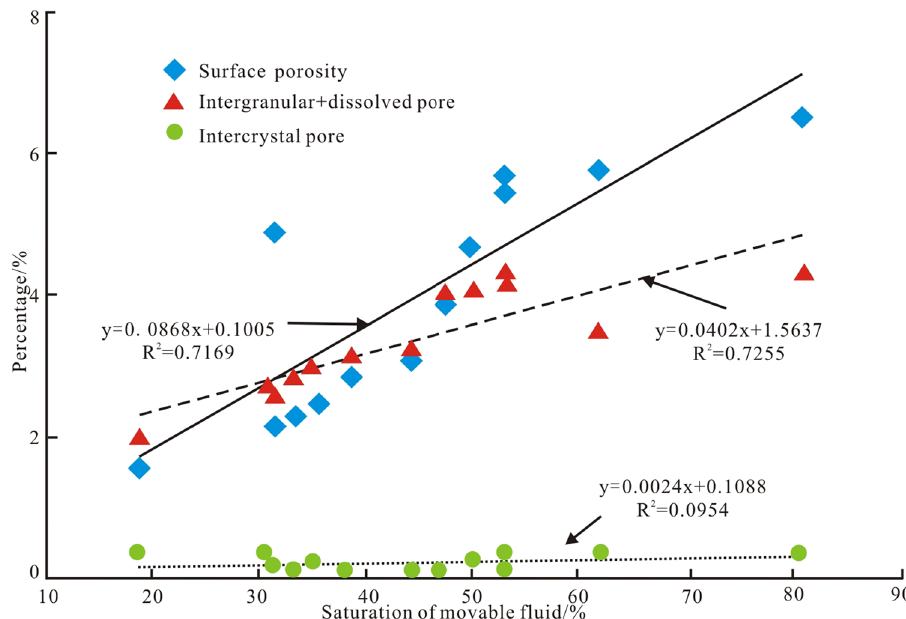
Table 3 Characteristic parameters of microscopic pore structures of Chang 8 Sample ID Well ID Total pore mercury